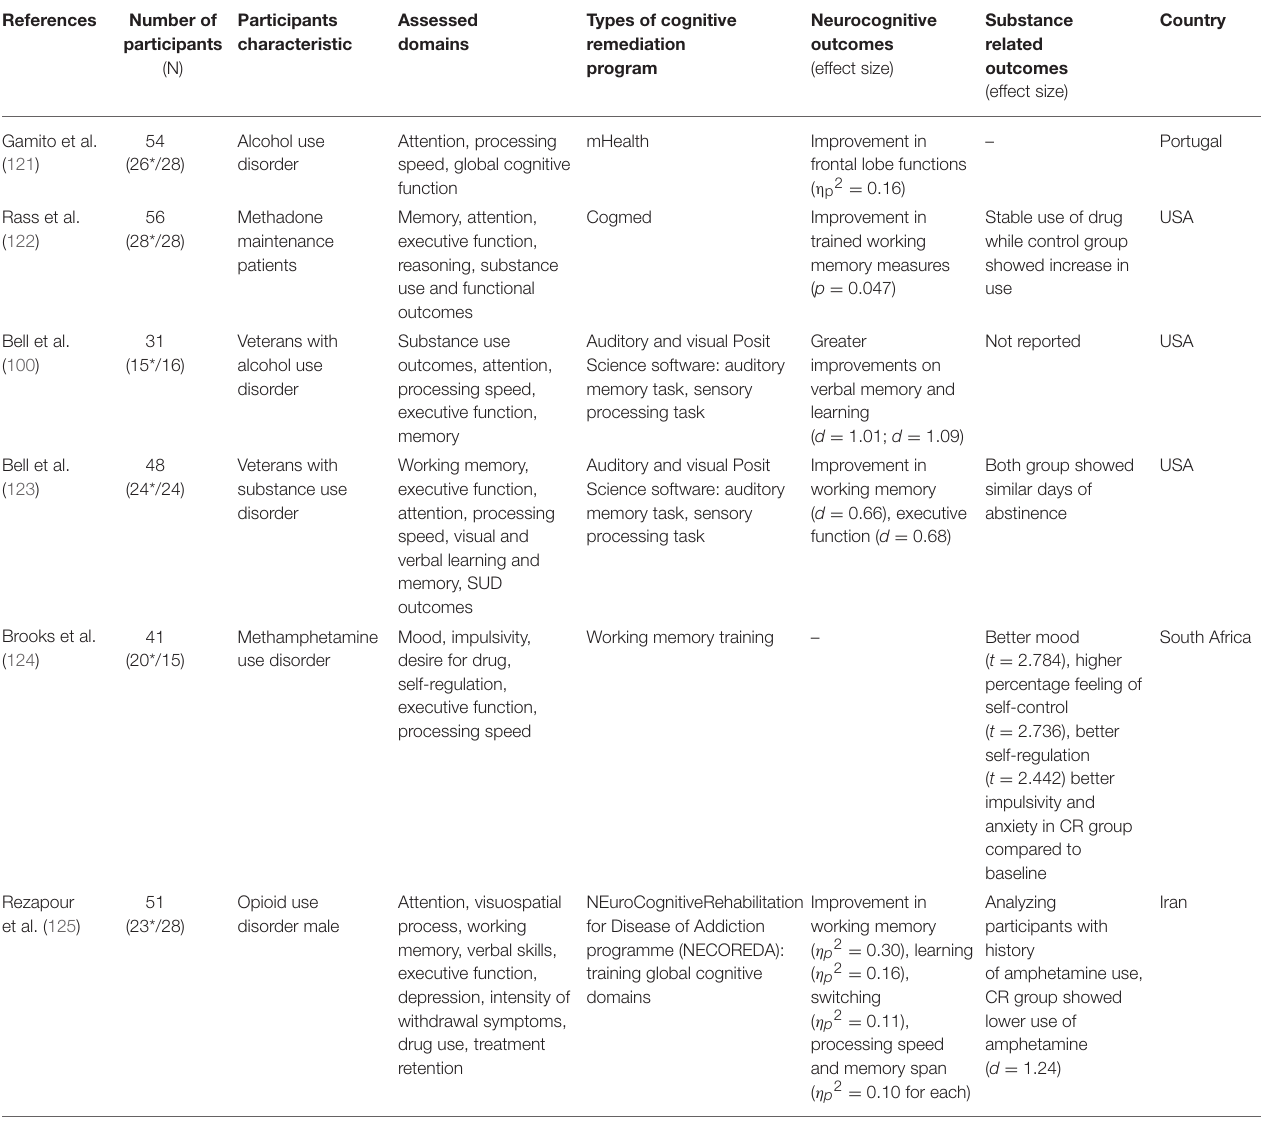
TABLE 6 | RCT studies on CR effect on substance use